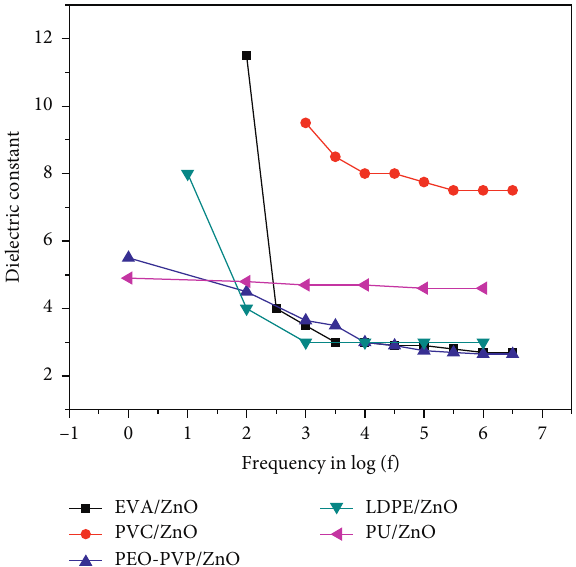
Figure 12: Variation of the dielectric constant of various polymer- based ZnO nanocomposites with respect to frequency.